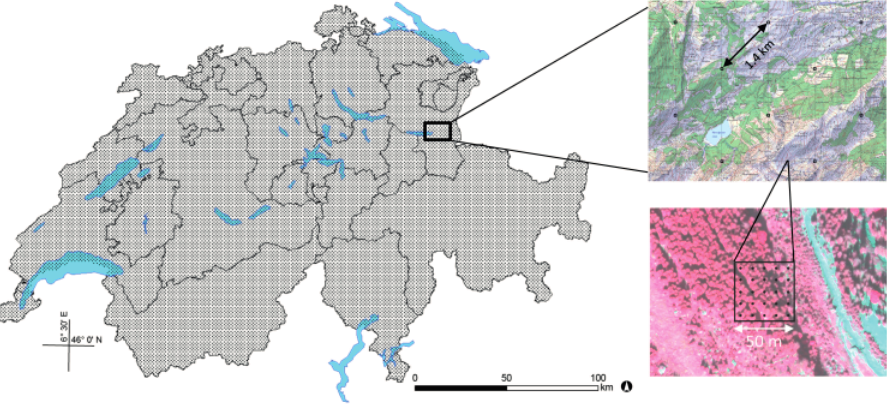
Figure A5. Sample plots of the Swiss National Forest Inventory spaced in a regular 1.4 km grid, consisting of 25 lattice points each where height and surface cover information was